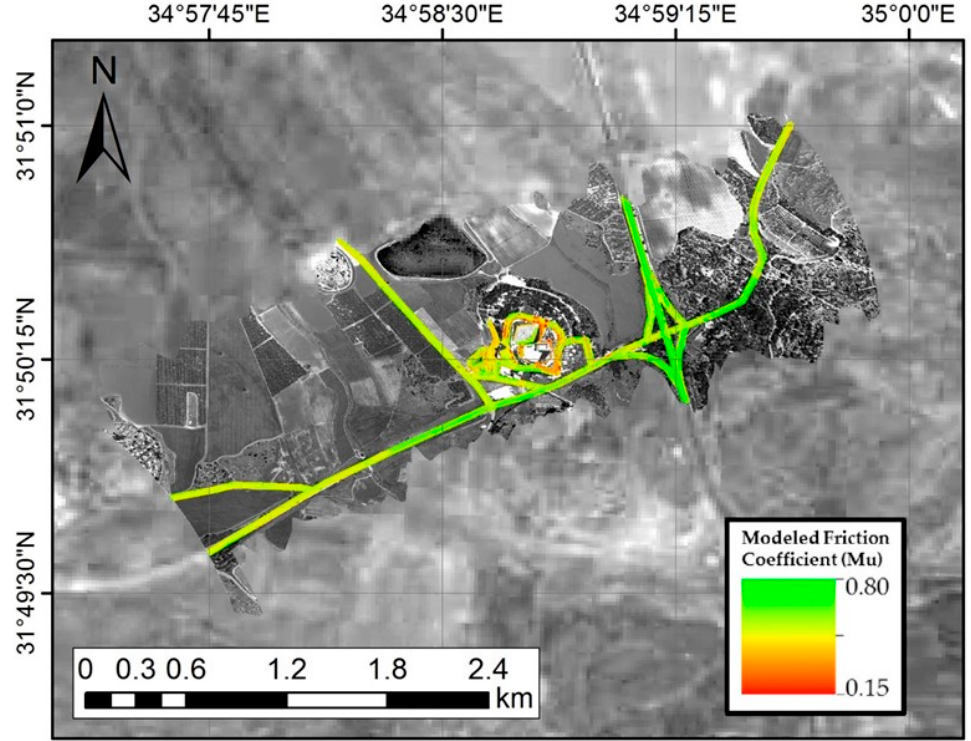
Figure 6 . Roads predicted friction map of the study site Figure 6. Roads predicted friction map of the study